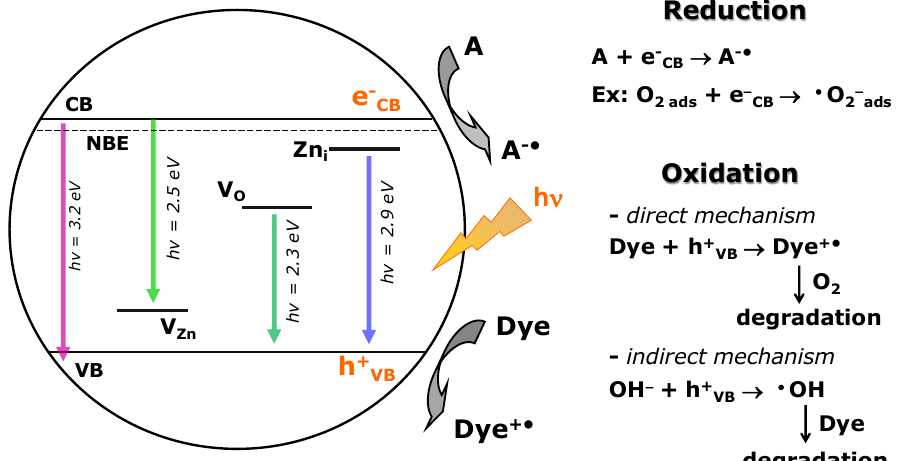
Figure 7. Schematic representation of the electronic structure of zinc oxide. The energetic levels of the main point defects in zinc oxide are assigned, as well as the main radiative recombination recognized in the literature. The scheme of the band gap absorption-initiated path of simultaneous photocatalytic electron acceptor molecules (e.g., O 2 ) reduction and electron donor species (e.g., OH- groups or dye molecules)